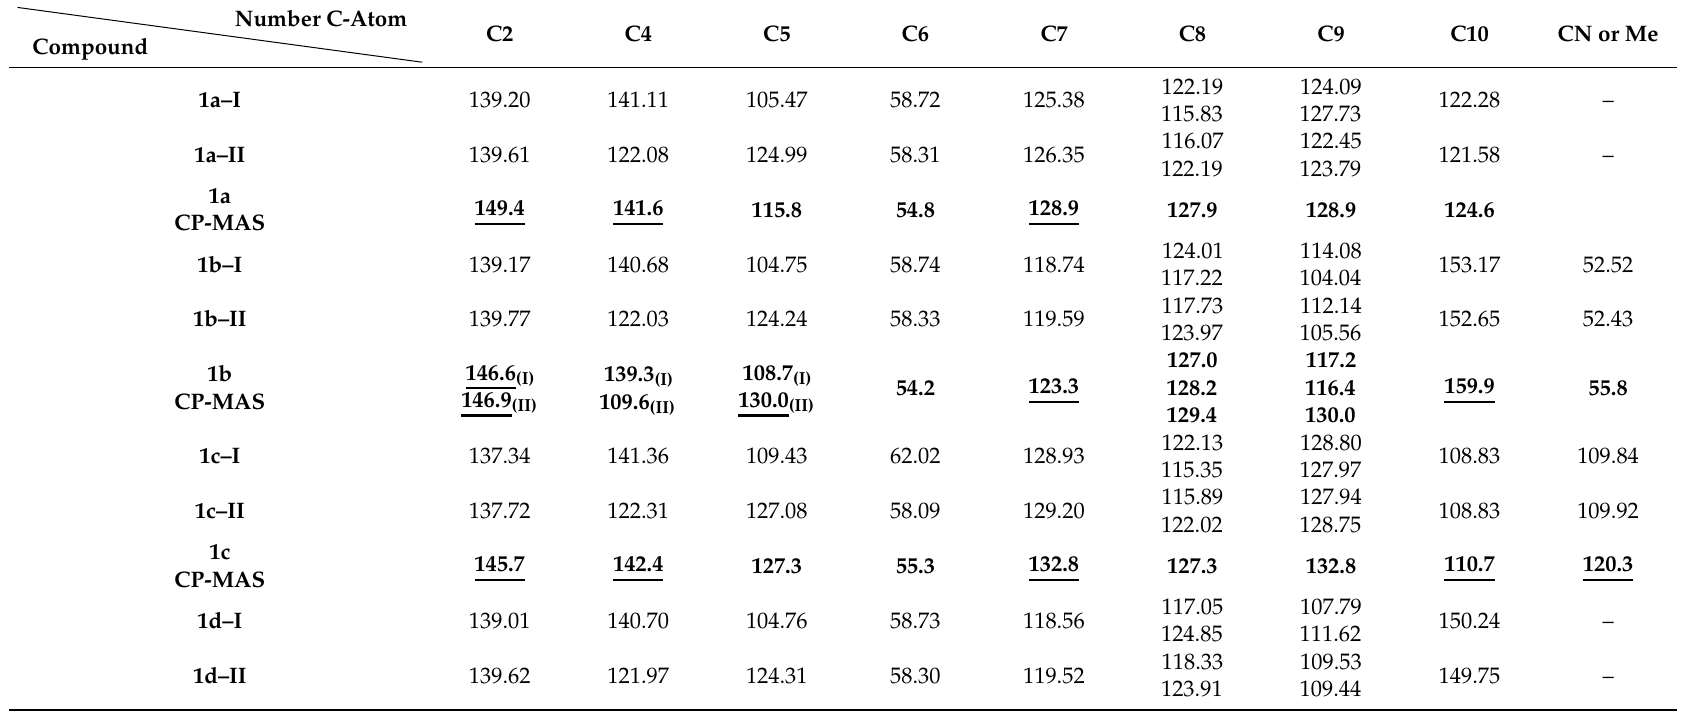
Table 3. Experimental (CP-MAS in bold) and calculated (GIAO-B3LYP-6-31G(d,p)) 13 C NMR shifts of compounds 1a – d (the shifts for quaternary carbon atoms are underlined). Calculated data are given for the two most stable forms (form I and form II ), shown in Figure 1 and Figure 7. Compound 1d is studied only theoretically. For compound 1b , distinct signals for tautomers I and II could be assigned from the cross-polarization / polarization-inversion (CPPI) and 1 H- 13 C HETCOR MAS NMR